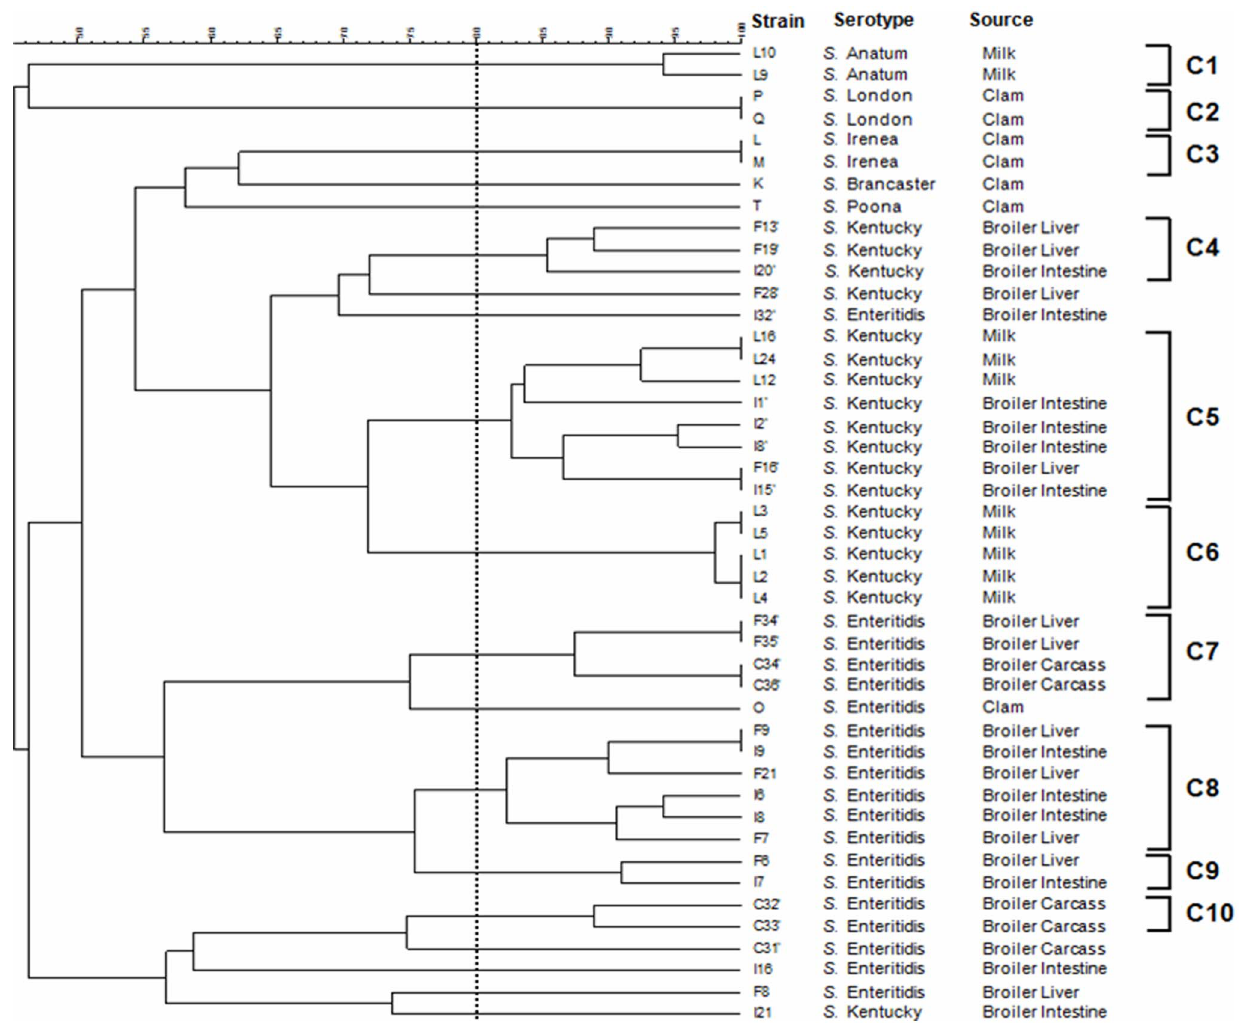
Figure 5. Dendrogram showing the percentage of similarity between typable Salmonella isolates generated from composite fingerprinting. Genetic similarity between samples in duplicate is 80%.